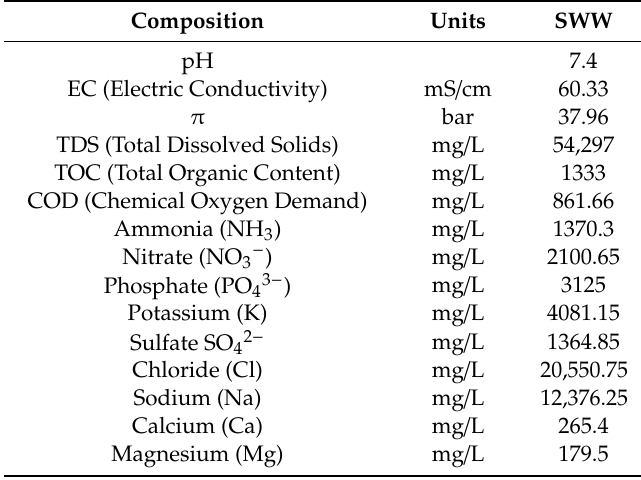
Table 1. Synthetic wastewater (SWW)